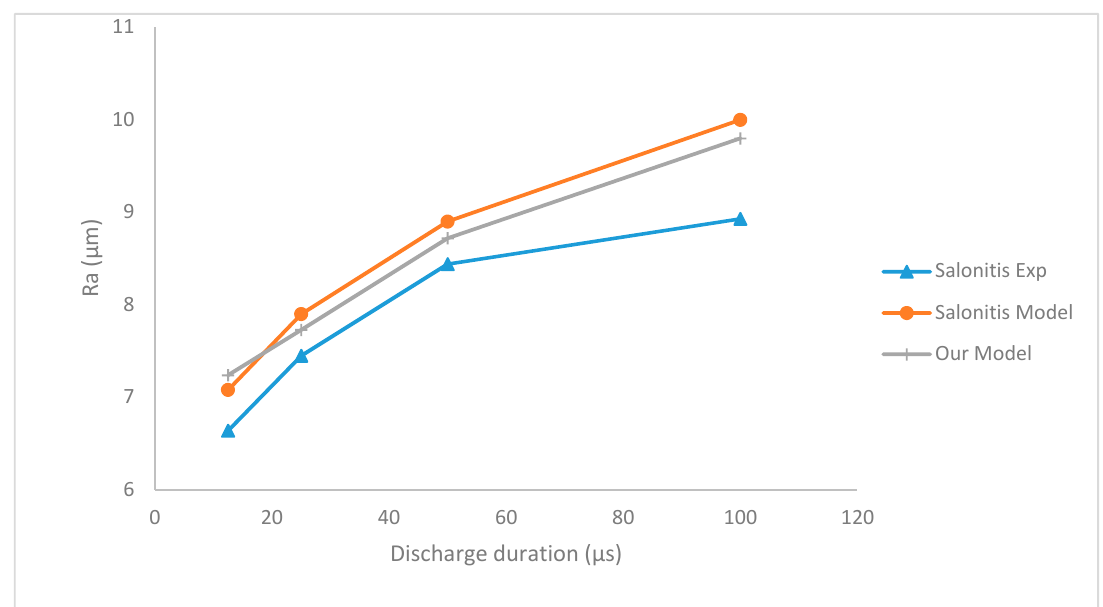
Table 2. Performance parameters of surface roughness simulation.